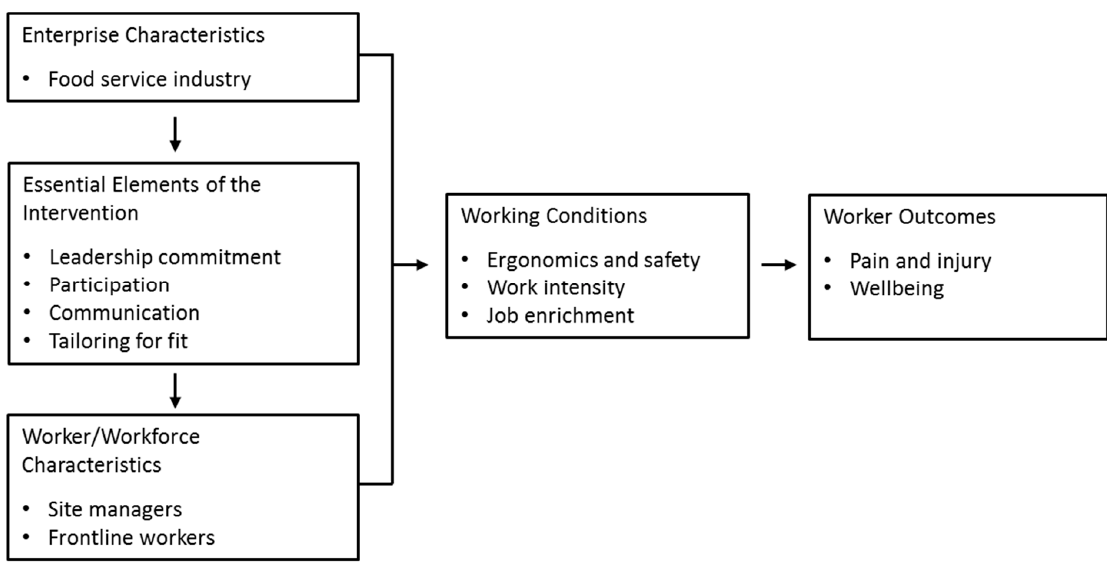
Figure 3. Conceptual Model.